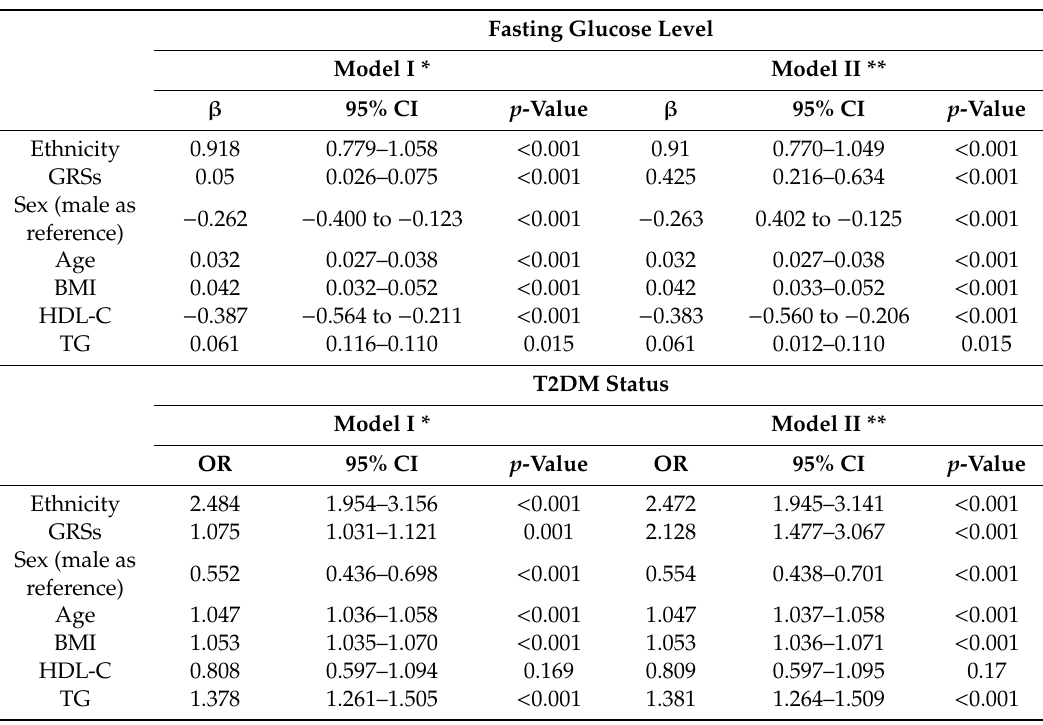
Table 7. Association of ethnicity (Hungarian general was used as reference) with fasting glucose level and T2DM